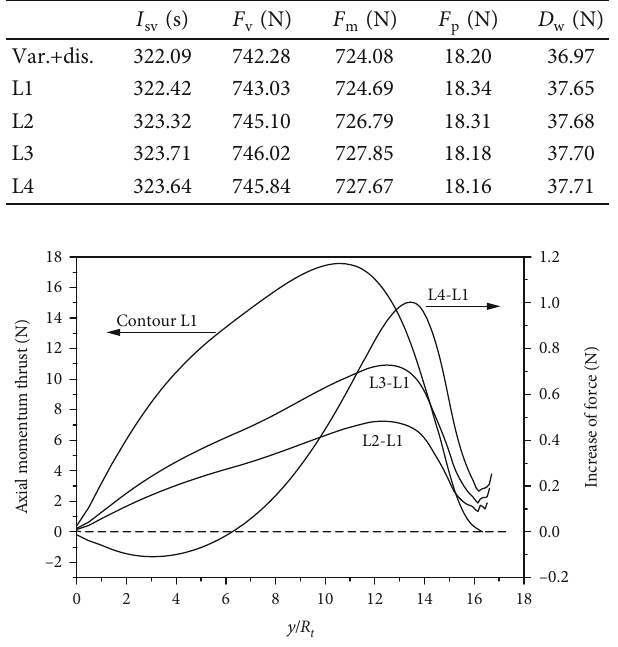
Figure 11: Axial momentum force along the radius.